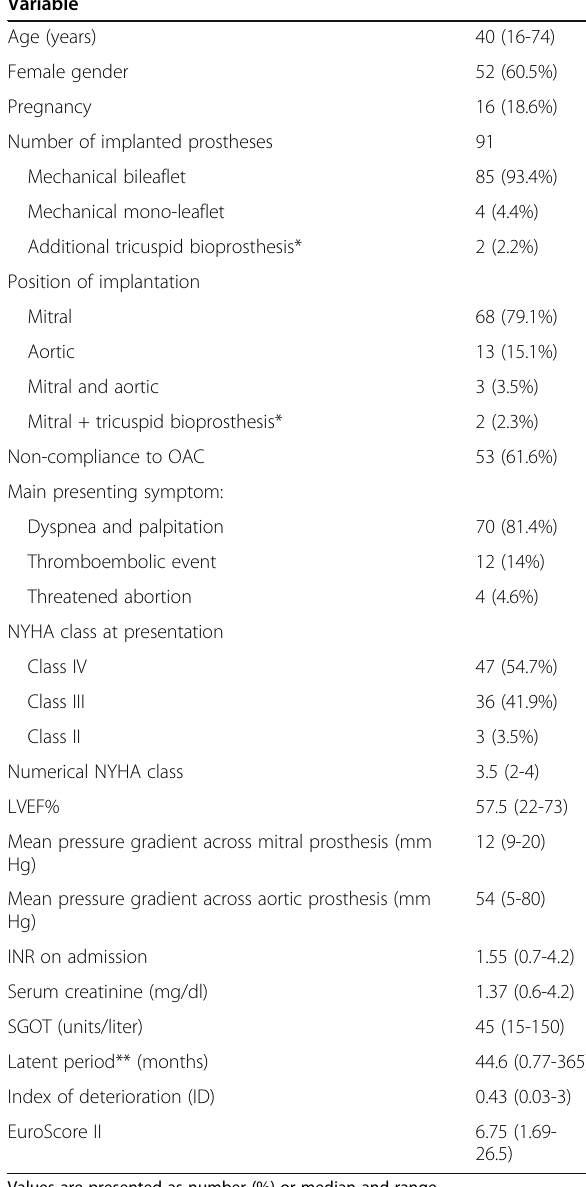
Table 1 Patients ’ demographics ( n =